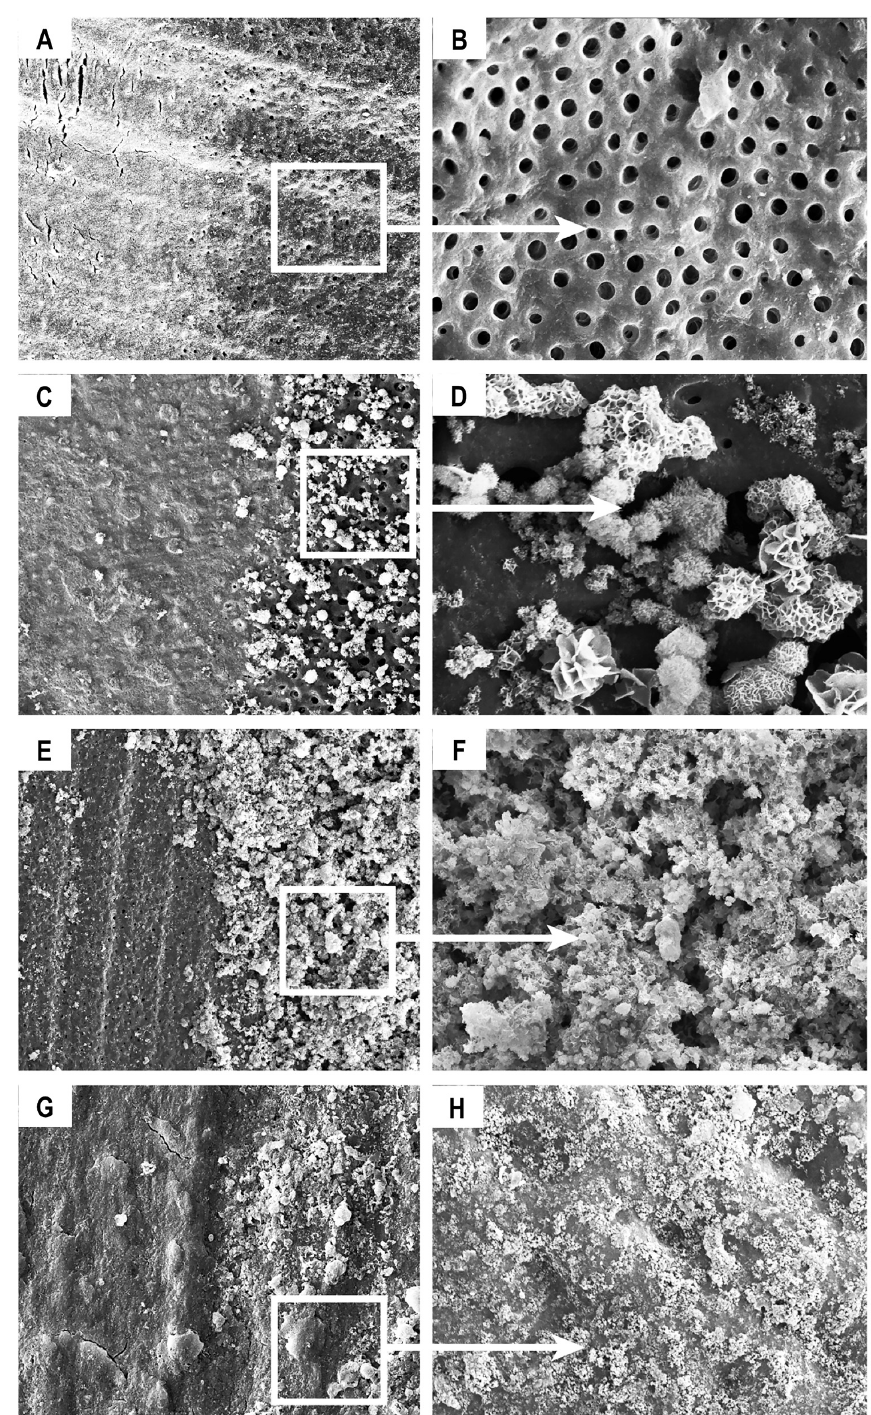
Figure 3. Photomicrographs of partially demineralised dentin as a template for remineralisation. Scanning electron microscopy (SEM) analysis showed ( A ) partially demineralised dentin (500 × ) and ( B ) permeable tubules (2000 × ); ( C ) precipitate formation exclusively over the demineralised dentin surface (500 × ) and ( D ) inside the intratubular dentin area (5000 × ); E (250 × ), F (2000 × ) thickening of the mineralised layer exclusively over the demineralised dentin at day 60; and G (2000 × ), H (5000 × ) remineralisation of radicular dentin was observed (4 months). Control dentin is shown on the left-hand side of panels a, c, e, and g. Uncropped SEM images in Supplementary Material—Figure